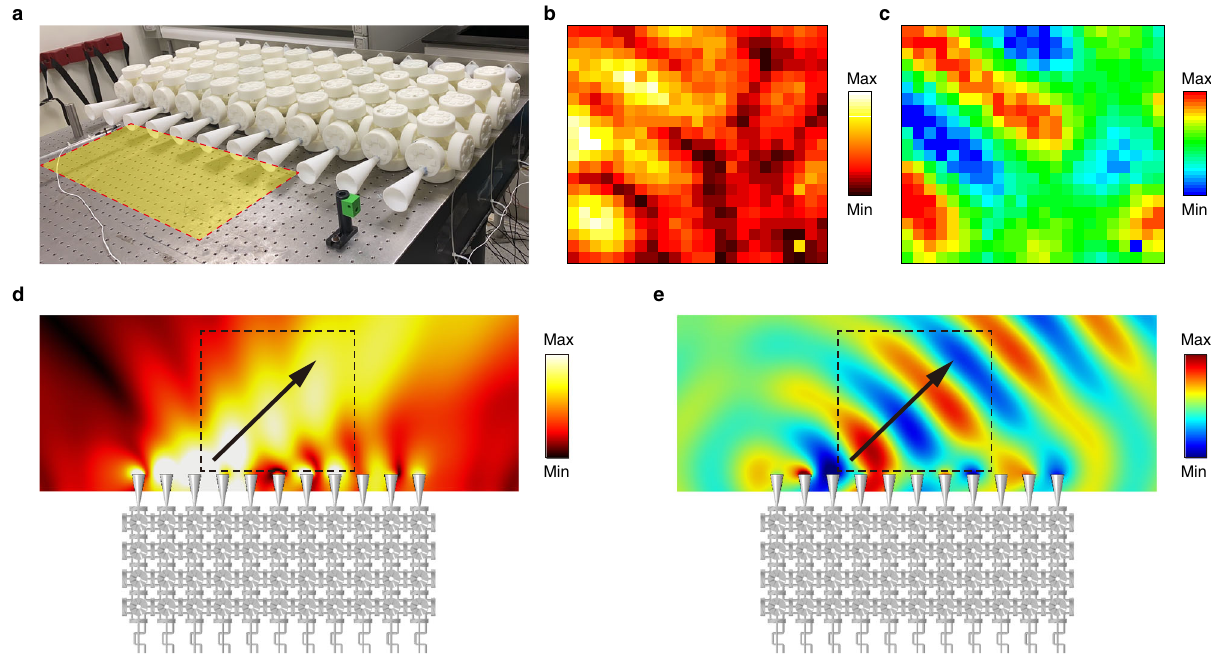
Fig. 5 Experimental demonstration of the negative refraction. a A photograph of the metamaterial lattice and the measurement area (yellow colored). b The amplitude and ( c ) the real part of the measured pressure fi eld. d The amplitude and ( e ) the real part of the simulated pressure fi eld. The dashed boxes indicate the corresponding measurement area in the